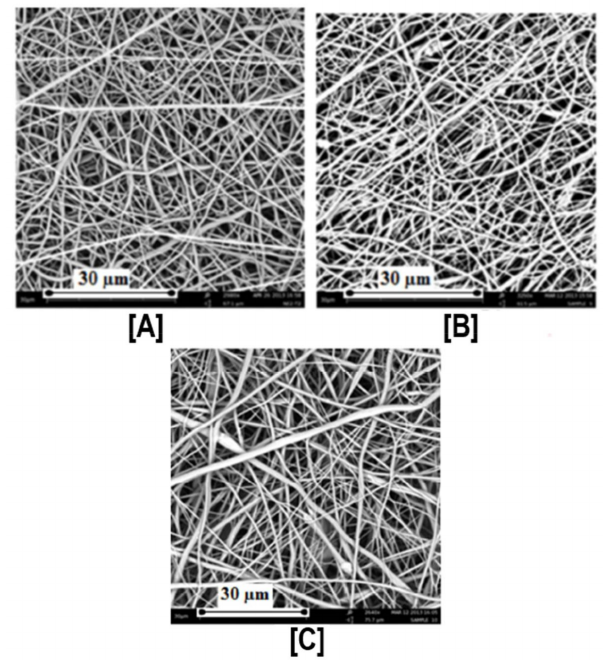
Figure 2. Scanning Electron Micrographs (SEM) of PCL and PCL/ γ -CD functionalized nanofibers. By simply adjusting the PCL concentration from 14% to 12%, an increase in γ -CD loading (from 15% to upwards of 30%) was made possible without significant increases in the beaded structures in the nanofibers ( A – C ). Images adapted and reproduced with permission from [42]. Copyright American Chemical Society 2014.